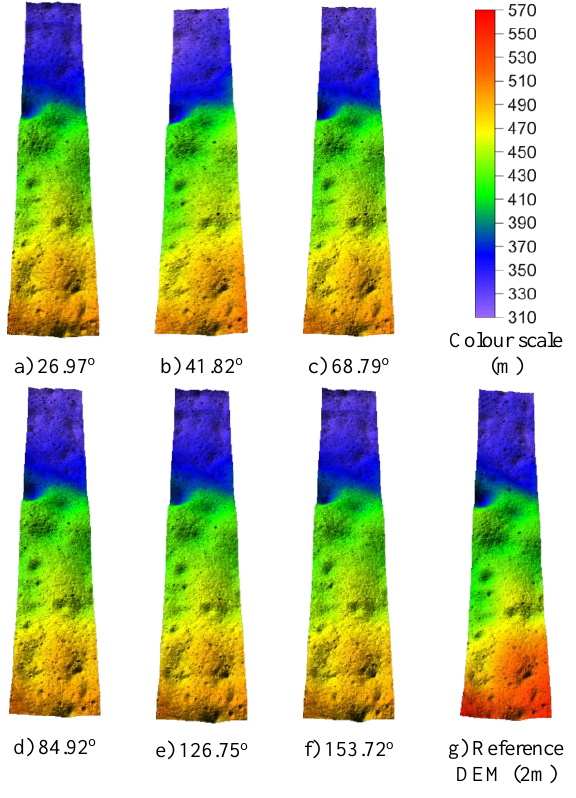
a) Maximum vertical error (vertical axis: 40m-70m)